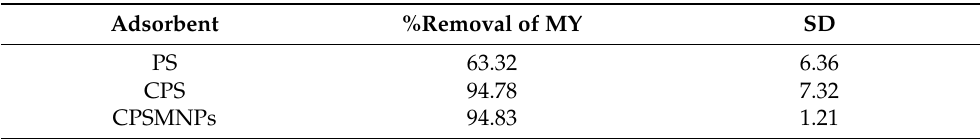
Table 3. Comparison of PS and CPS with CPSMNPs for the adsorption of MY using the same effecting